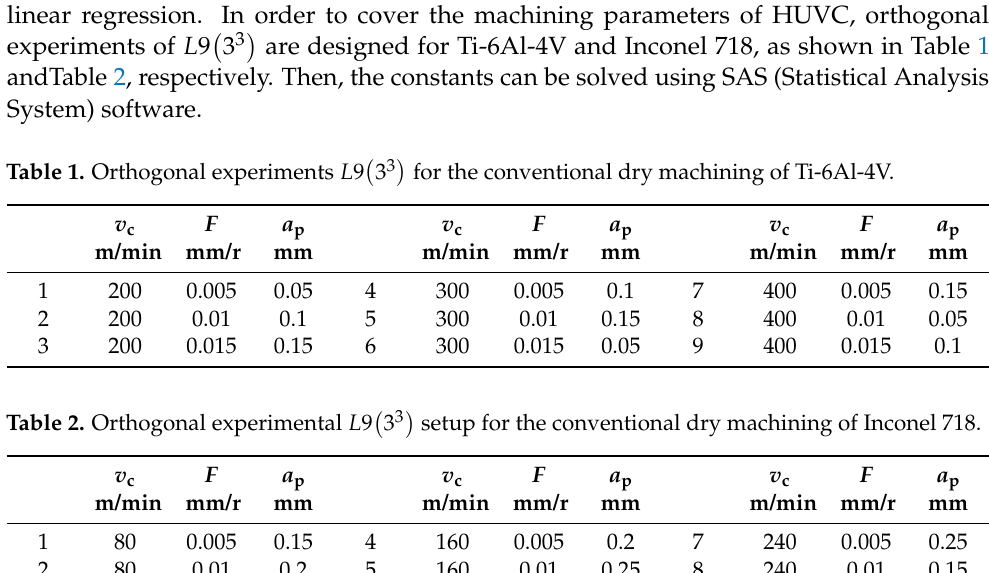
(cid:0) (cid:1) 3 3 for the conventional dry machining of Ti-6Al-4V.